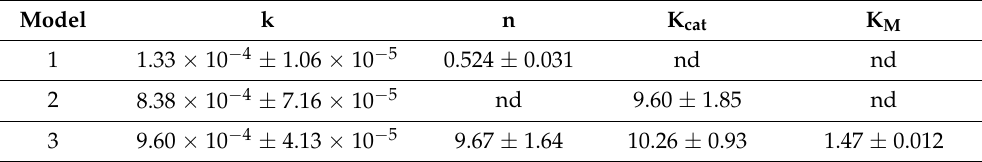
Table 1. Values and standard errors of the kinetic constants calculated by fitting the kinetic models to experimental results retrieved at 80 ◦ C and diverse catalyst concentrations as well as reagent molar ratios.